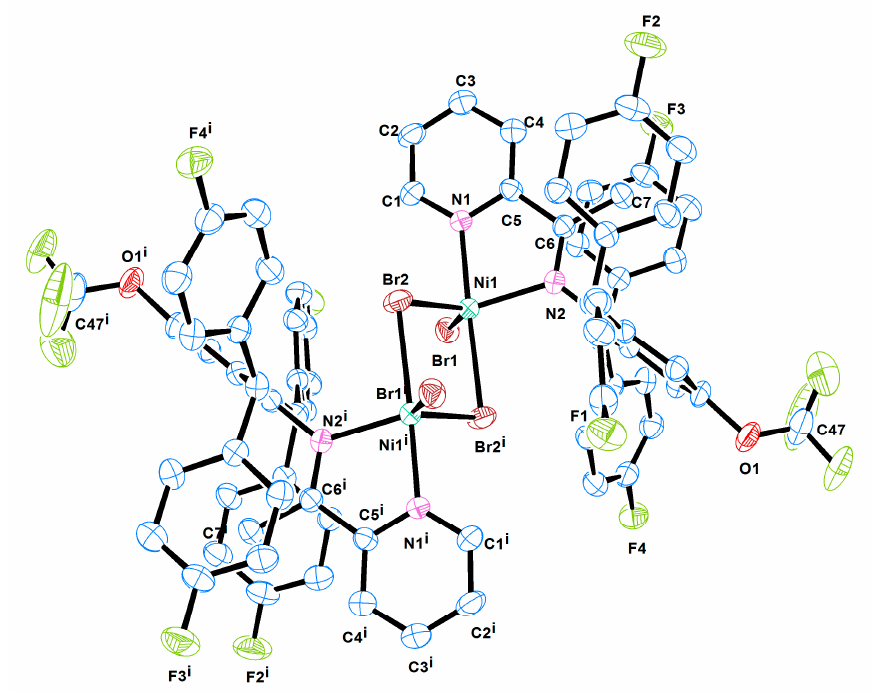
Figure 2. ORTEP drawing of Ni5 with thermal ellipsoids shown at a probability level of 30%. All the hydrogen atoms have been omitted for clarity. The atoms labelled with an ‘i’ superscript have been generated by symmetry.